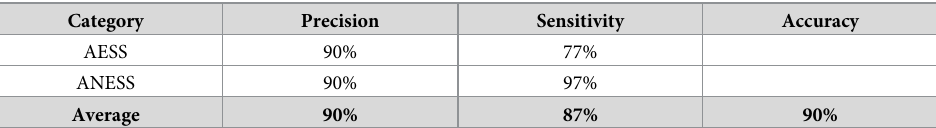
Table 7. Overall performance of the SEAC